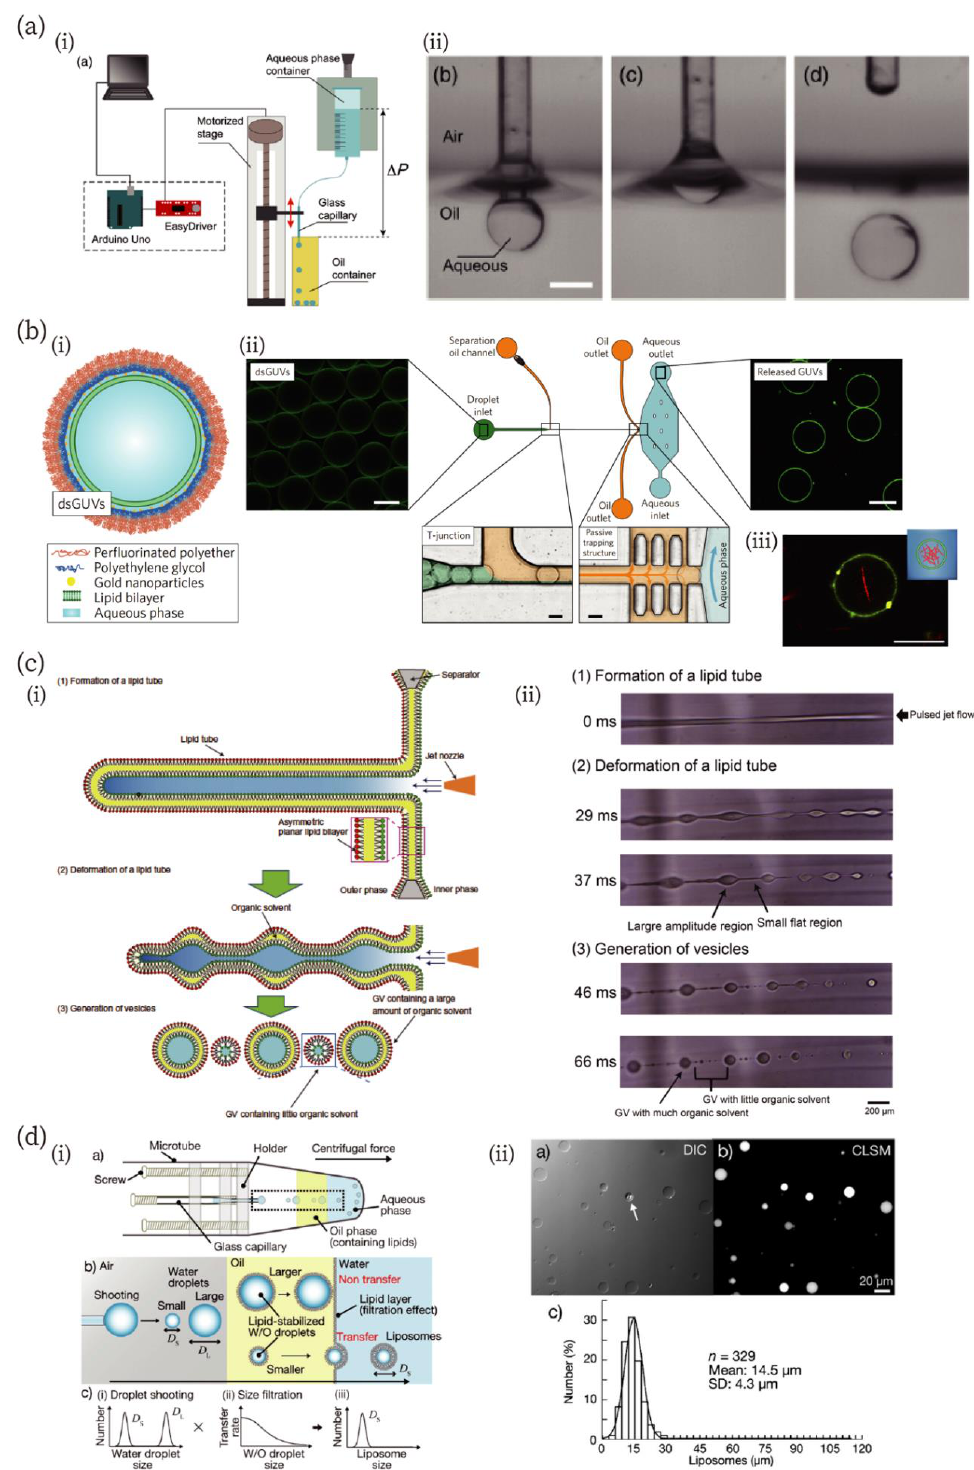
Figure 2. cell-compartments. ( a ) A low-cost capillary-based fabrication method of W / O emulsion [66]. (i) An illustration of the low-cost setup. (ii) Snapshots of processes of droplet fabrication. Scale bar: 400 µ